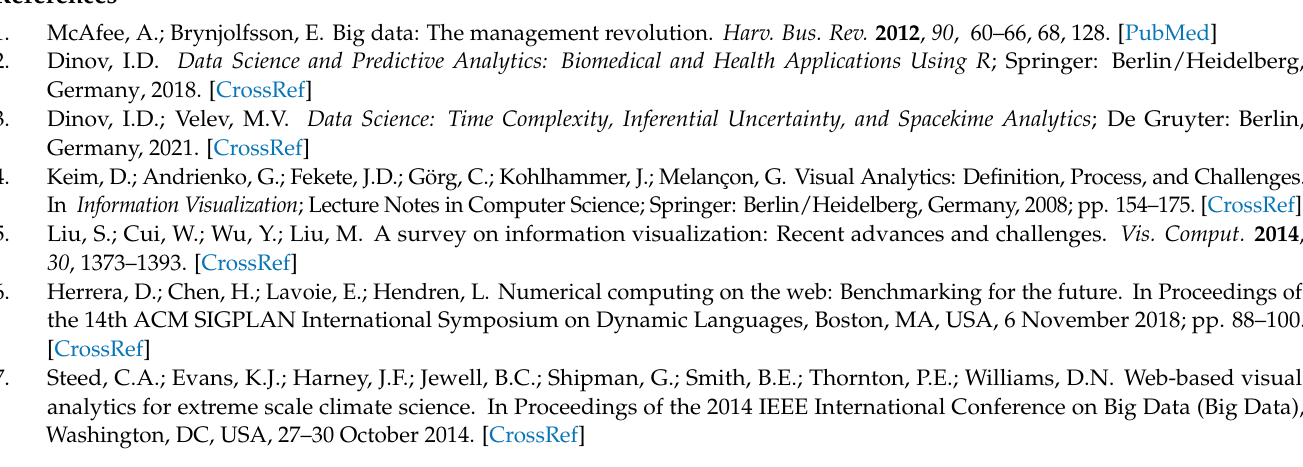
Figure A2. An example of the D³ chart implemented within the SOCRAT platform. Visual elements: ( 1 ) sidebar and ( 2 ) main area are two main UI components of any SOCRAT module; ( 3 ) additional control shows an interactive slider that allows to easily extend the standard D³ graphing capabilities within the application, ( 4 ) D³ histogram chart generated within the main area of the SOCRAT application. Corresponding SOCRAT module specification consists of ( 6 ) a config definition of the Charts module that includes ( 5 ) the module state, with url and main menu name components, as well as controllers and templates for ( 1 ) sidebar and ( 2 ) main area. D³ is also: ( 7 ) included as a global SOCRAT dependency and ( 8 ) injected directly into a service